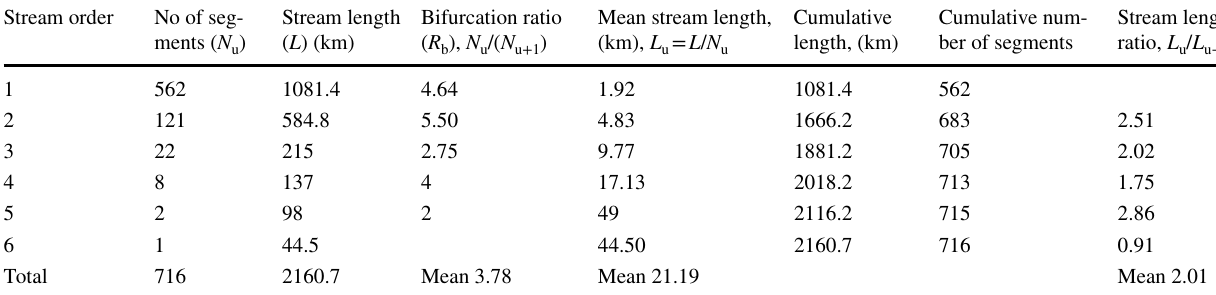
Table 4 Morphometric characteristics of Arkavathy river basin Stream